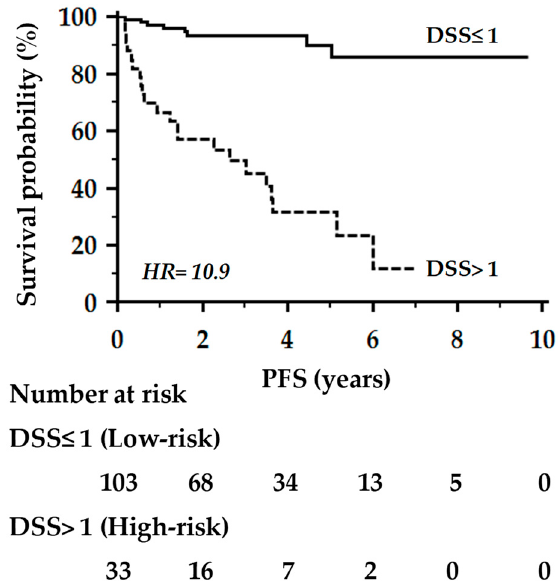
Figure 1. Kaplan–Meier curves of progression-free survival (PFS) of the 136 BC women included in the testing set. Comparison between patients at high (>1) or low-risk ( ≤ 1) of progression by the combined decision support system (DSS) model.